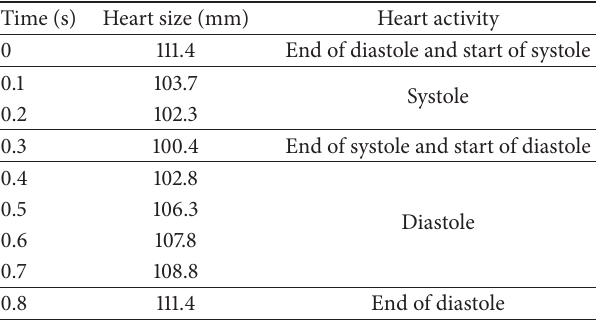
Figure 2: Variation of transverse dimension of normal human heart with time during a cardiac cycle. Table 1: Instantaneous dimensions of human